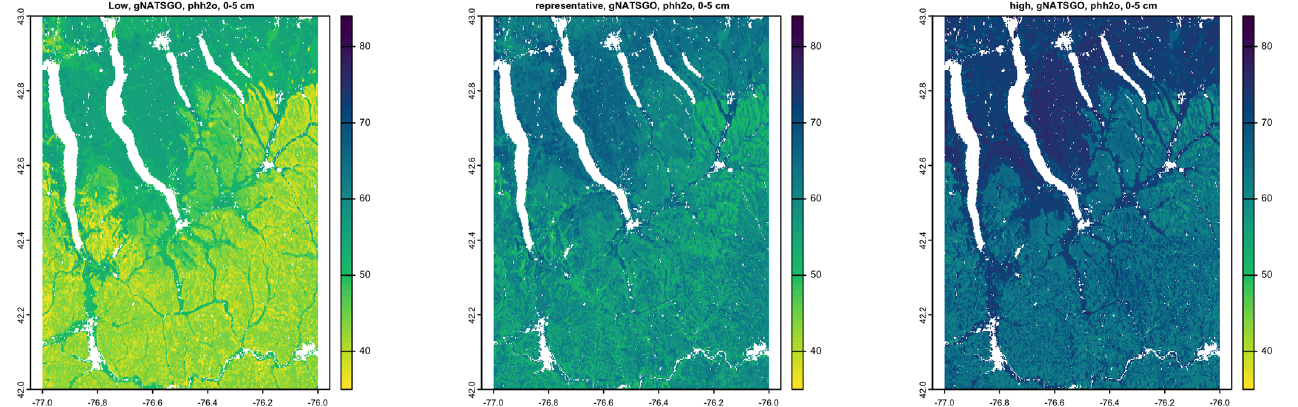
Figure 11. Low, representative, and high values from gNATSGO for pH × 10 at 0–5cm.